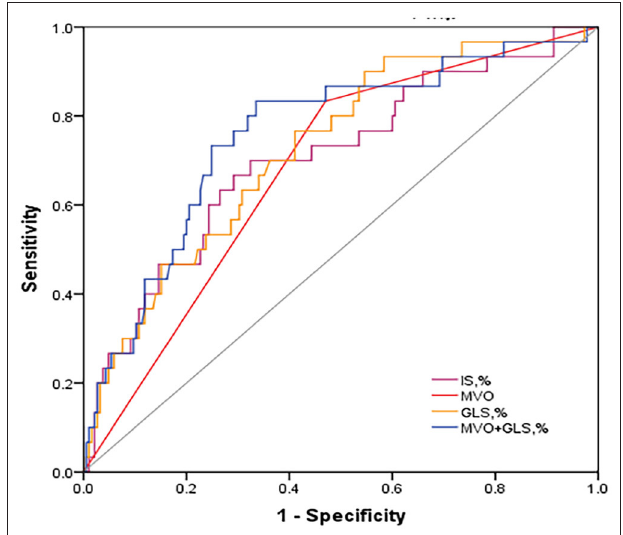
FIGURE 2 | Discriminative prognostic power of MVO, IS, GLS and MVO combined with GLS. ROC curves of them for the prediction of MACE. MVO combined with GLS revealed a significantly higher AUC (0.759, 95% CI: 0.663–0.854, P < 0.001) with 83.3% sensitivity and 66.5% specificity. ROC, receiver operating characteristic; AUC, area under the curve; MACE, major adverse cardiac events; GLS, global longitudinal strain; IS, infarct size; MVO, microvascular obstruction.